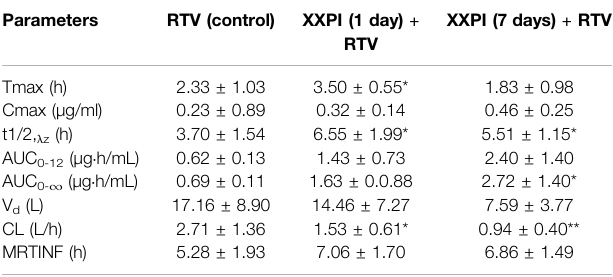
TABLE 2 | Pharmacokinetic parameters of RTV after oral administration of LPV/ RTV (42:10.5 mg/kg) in rats that were pretreated with or without XYPI (x ( ) ± SD, n (cid:1) 6).